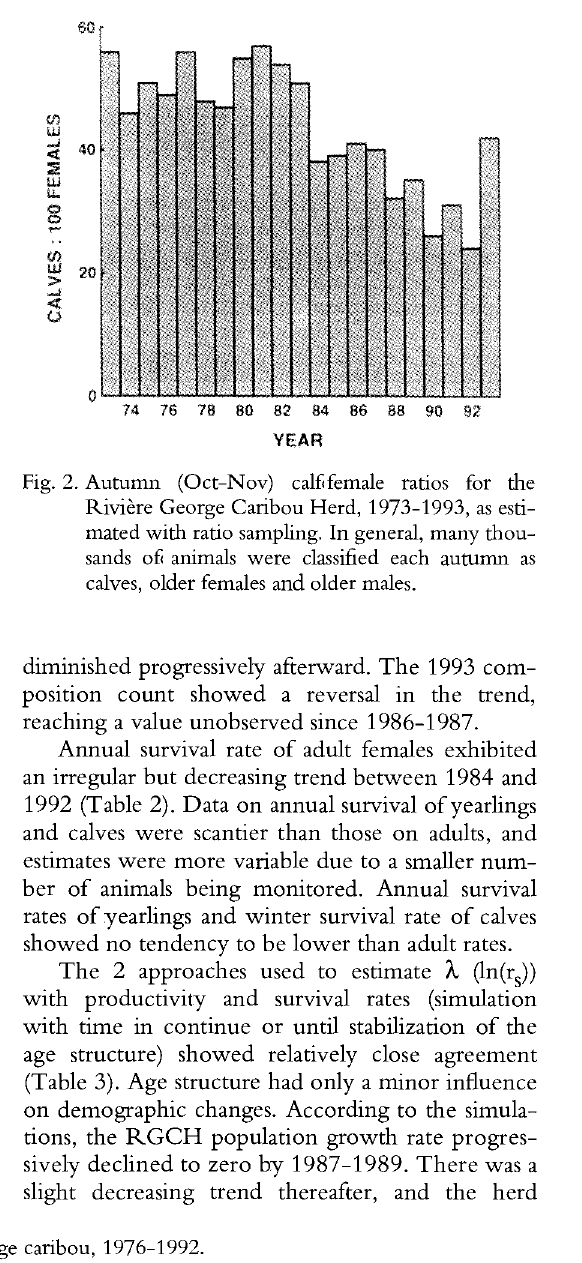
Age (years) during the breeding season